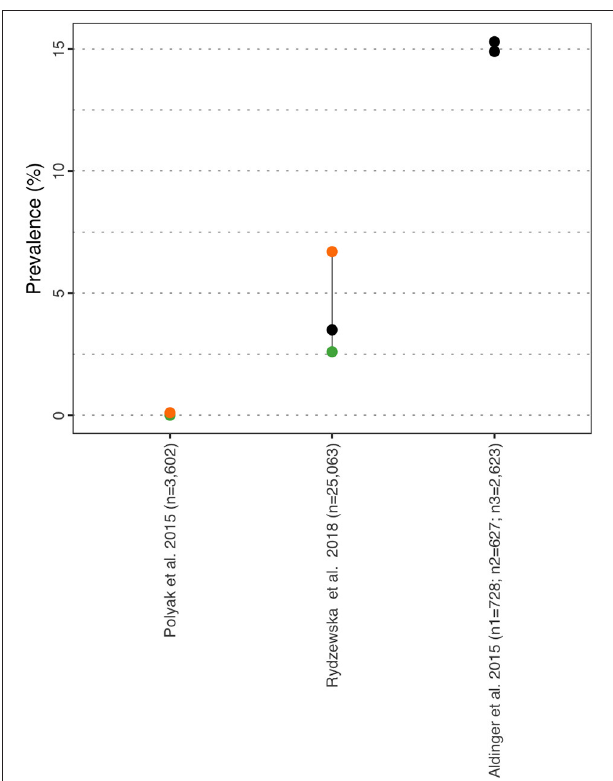
FIGURE 11 | Vision impairment prevalence estimate. Each point reports a prevalence estimate for the related comorbidity. Studies with more than one data point indicate the estimate of the prevalence among different subgroup of the population. See Supplementary Table 4 for the description of the population used in each study. Sample sizes are shown in brackets above each study label. Orange mark: Female population only; Green mark: Male population only; Black mark: No sex